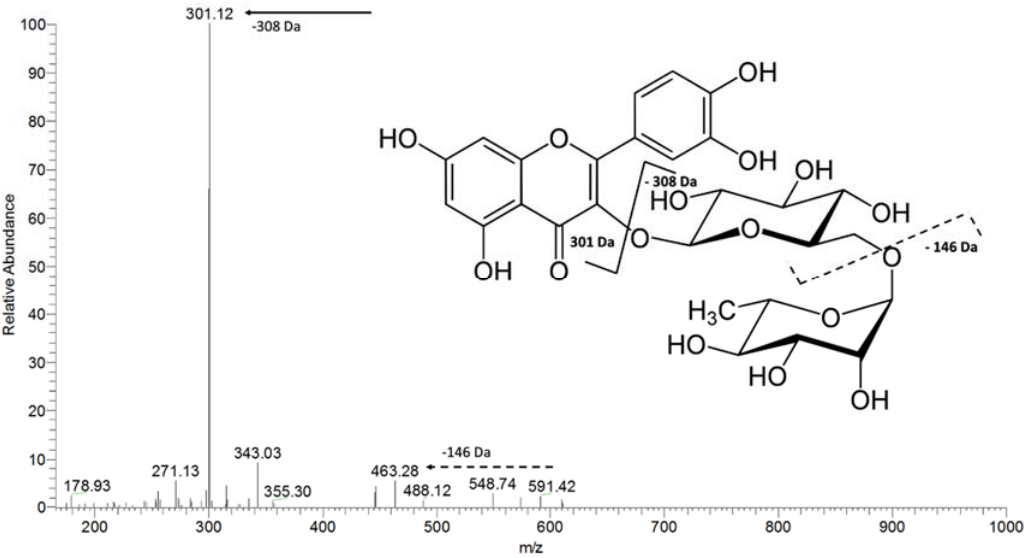
Figure 7. The MS² spectrum of the ion at m / z 609, evidencing the main patterns of fragmentation of rutin.